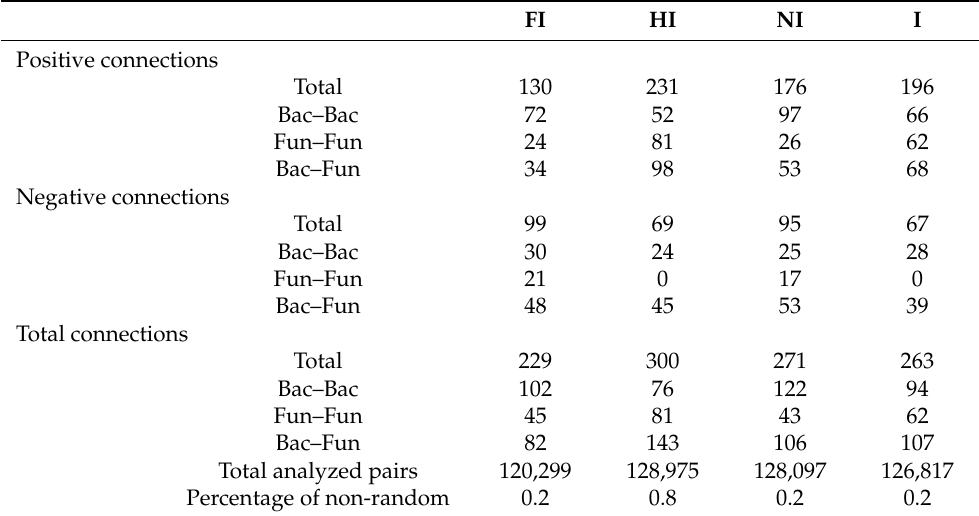
Table 4. Degree of connection for bacterial and fungal communities in Merlot vineyard soils subjected to different irrigation amounts (FI, fully irrigated, or HI, half irrigated) or AMF inoculation (I, inoculated, or NI,